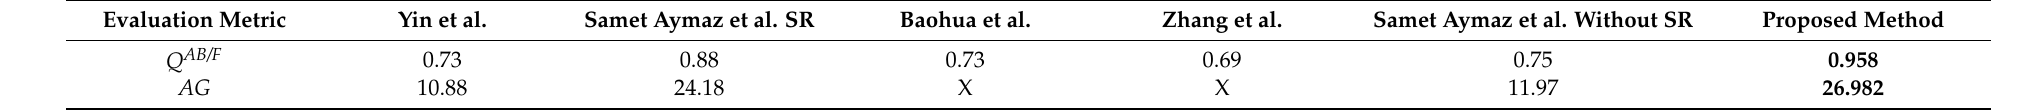
Table 31. The outcomes for the leaf image and comparisons with existing techniques in the literature ([24]). Evaluation Metric Yin et al. Samet Aymaz et al. SR Baohua et al. Zhang et al. Samet Aymaz et al. Without SR Proposed Method